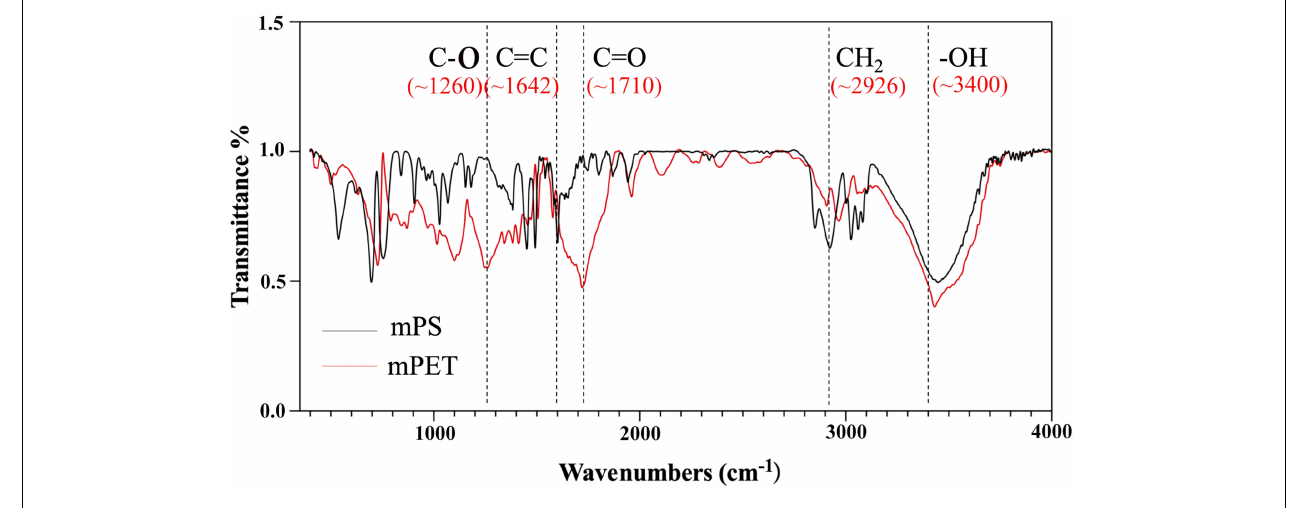
FIGURE 2 | Infrared absorption spectrum of mPS and mPET.